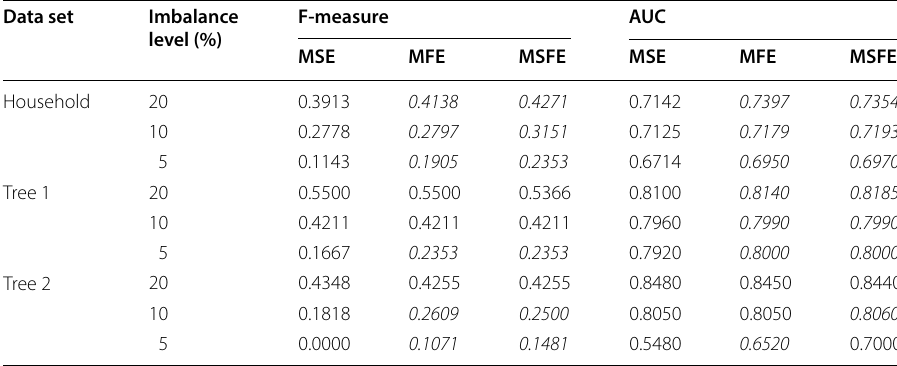
Italic scores indicate MFE/MSFE loss outperforming MSE loss Table 8 20 Newsgroup classification with MFE and MSFE[18] Data